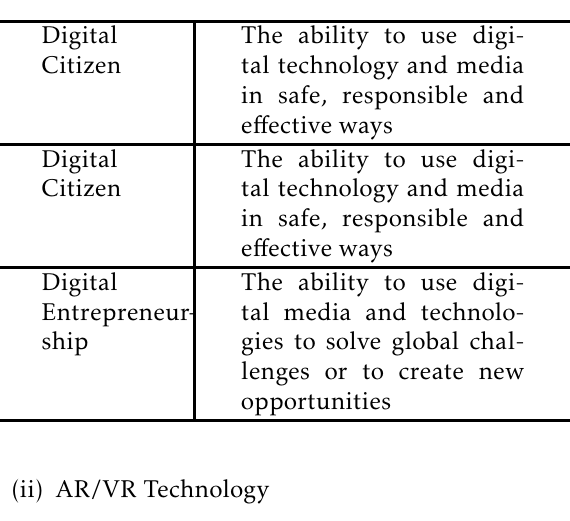
Table 1. Level of Digital